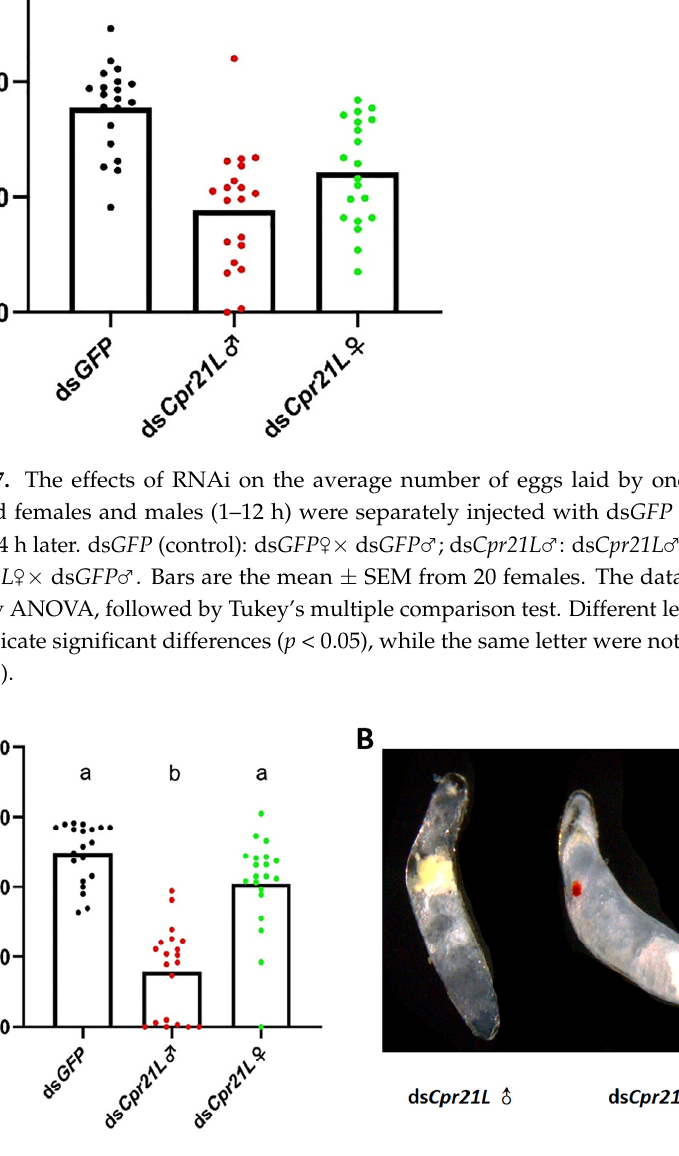
Figure 8. The effects of RNAi on the egg development and hatchability of BPH. ( A ) Egg hatching rate. ( B ) Eggs laid by the BPH and isolated from the rice leafsheath. Newly emerged males and females (1–12 h) were separately injected with ds Cpr21L or ds GFP (control), and 6 days later the eggs were isolated. ds GFP (control): ds GFP ♀ × ds GFP ♂ ; ds Cpr21L ♂ : ds Cpr21L ♂ × ds GFP ♀ ; ds Cpr21L ♀ : ds Cpr21L ♀ × ds GFP ♂ . Bars are the mean ± SEM from 20 females. The morphology of 6 ‐ day ‐ old eggs was observed. Scale bar = 100 μ m. Different letters ʺ a ʺ and ʺ b ʺ on the bars indicate significant differences ( p < 0.05), while the same letter were not significantly different (P < 0.05).In normal situations, involving a normal egg, normal sperm, and successful fertilization, the fertilized egg or embryo will develop well, and red ‐ eye spots are expected to occur at the 5th day post ovi ‐ position. To investigate why the eggs’ hatchability in the ds Cpr21L ♂ × ds GFP ♀ group was low, the eggs were isolated from the rice leafsheath and observed under a stereomicroscope. The result showed that most of the eggs (embryo) from the ds Cpr21L ♀ × ds GFP ♂ group showed obvious red ‐ eye spots, suggesting that the RNAi of the ds Cpr21L did not affect the quality of the eggs in the ds Cpr21L treated females; therefore, if these eggs were well fertilized, the fertilized eggs were ex ‐ pected to develop normally, and nymphs could hatch from these eggs (Figure 8B, right). On the contrary, most of the eggs from the ds Cpr21L ♂ × ds GFP ♀ group did not show red ‐ eye spots, so it is possible that these eggs were unfertilized (Figure 8B, left). This strongly suggests that the RNAi of ds Cpr21L affects the quality and/or quantity of the sperm in the ds Cpr21L ‐ treated males. 2.6. RNAi of Cpr21L Resulted in Malformed Internal Reproductive Organ of Male Adult To analyze how the RNAi of Cpr21L impacted the fecundity of male adults, the morphology of the internal reproductive organ of male adults was examined. The results showed that the testes of the males injected with ds GFP developed well, and each testis displayed 3 pepper ‐ shaped branches (Figure 9A,C). In contrast, the males injected with ds Cpr21L were abnormal in the shape of the testes, and the testes did not display any pepper ‐ shaped branches. Instead, the branches of the testes treated with ds Cpr21L looked like small bubbles or sacs (Figure 9B,D). In addition, the vas deferentia of the males in the ds Cpr21L group showed some nodules. The results showed that the RNAi of the Cpr21L gene had a strong impact on the development of the internal reproductive organs of male BPH, which particularly affected the development of the testes (Figure 9D). However, no clear morphologic difference in the internal reproductive organs was observed between females treated with ds Cpr21L and those treated with ds GFP .